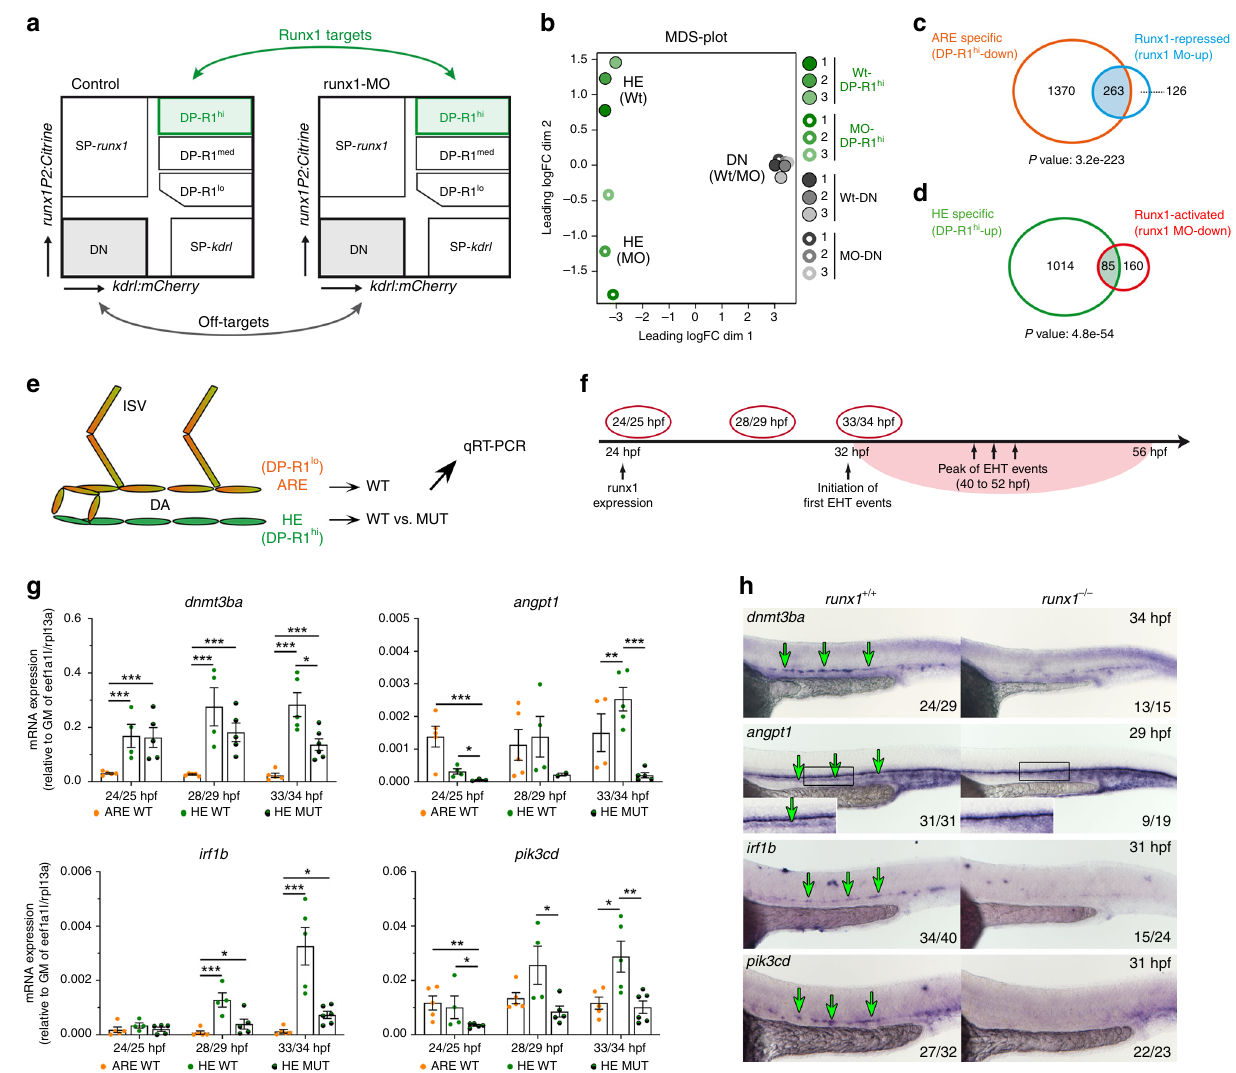
Fig. 4 Identi fi cation of Runx1-regulated genes within the aortic HE. a Experimental scheme to identify Runx1-regulated genes in the HE (DP-R1 hi ). Highlighted cell populations (DP-R1 hi and DN) from un-injected (control) and runx1 MO-injected double transgenic TgBAC(runx1P2:Citrine);Tg(kdrl:mCherry) embryos (28 – 30 hpf) were used for differential gene expression analysis (DEG) by RNA-seq similar to Fig. 3. b Multidimensional scaling plot (MDS-plot) analysis of the cell populations depicted in ( a ). c Gene list intersection between ARE-speci fi c and Runx1-repressed genes. d Gene list intersection between HE-speci fi c and Runx1-activated genes. e Experimental strategy to analyse potential HE-speci fi c Runx1 target genes by qRT-PCR in runx1 + / + (WT) and runx1 − / − mutant (MUT) embryos. f Timeline highlighting the time-points (red circles) used for subsequent qRT-PCR analysis. g qRT-PCR gene expression analysis of potential Runx1 targets ( dnmt3ba , angpt1 , irf1b and pik3cd ) in the HE and ARE of runx1 + / + (WT) and the HE of runx1 − / − mutant (MUT) embryos at the time-points depicted in ( f ). Graphs show the mean of detected expression levels relative to the geometric mean (GM) of the two housekeeping genes eef1a1l and rpl13a . n = 5 independent biological experiments for WT embryos and n = 6 independent biological experiments for MUT embryos. Error bars represent the SEM. 2-way ANOVA; * p < 0.05; ** p < 0.01; *** p < 0.001. h ISH analysis for the same genes analysed in ( g ) performed in runx1 + / +